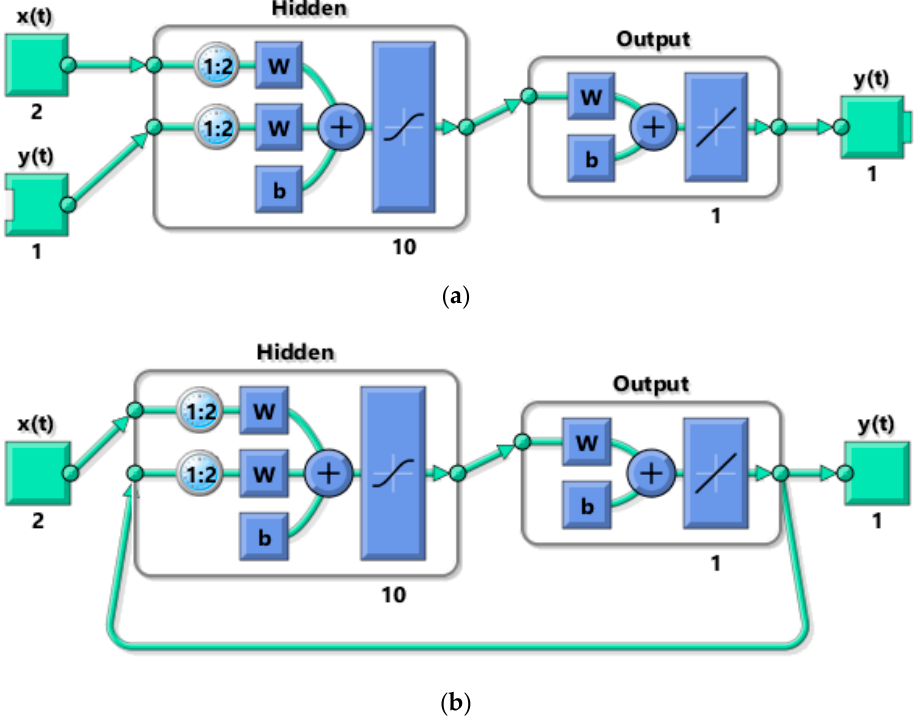
Figure 10. Structure of nonlinear autoregressive network with exogenous input (NARX) neural network: ( a ) open-loop architecture; ( b ) closed-loop architecture. Table 2. Training results for the open-loop NARX by data subset.